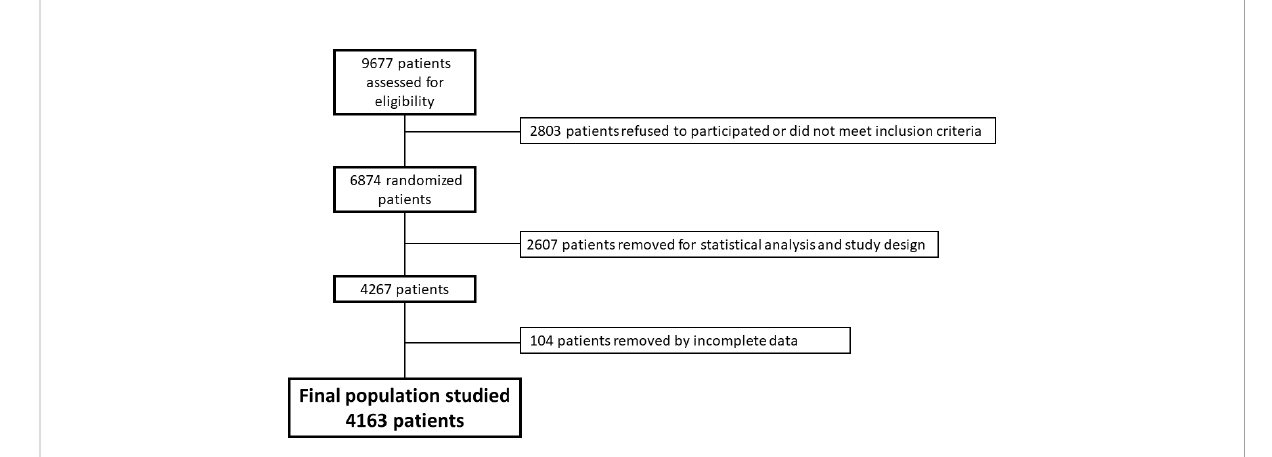
FIGURE 1 Flowchart of selection of studied